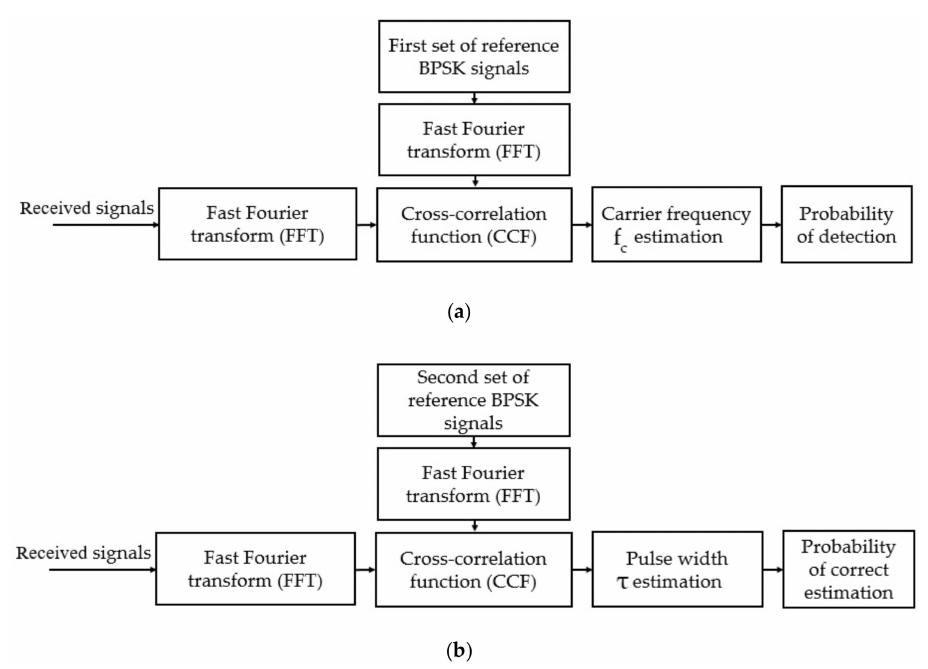
Figure 3. The proposed method: ( a ) detection process, and ( b ) pulse width